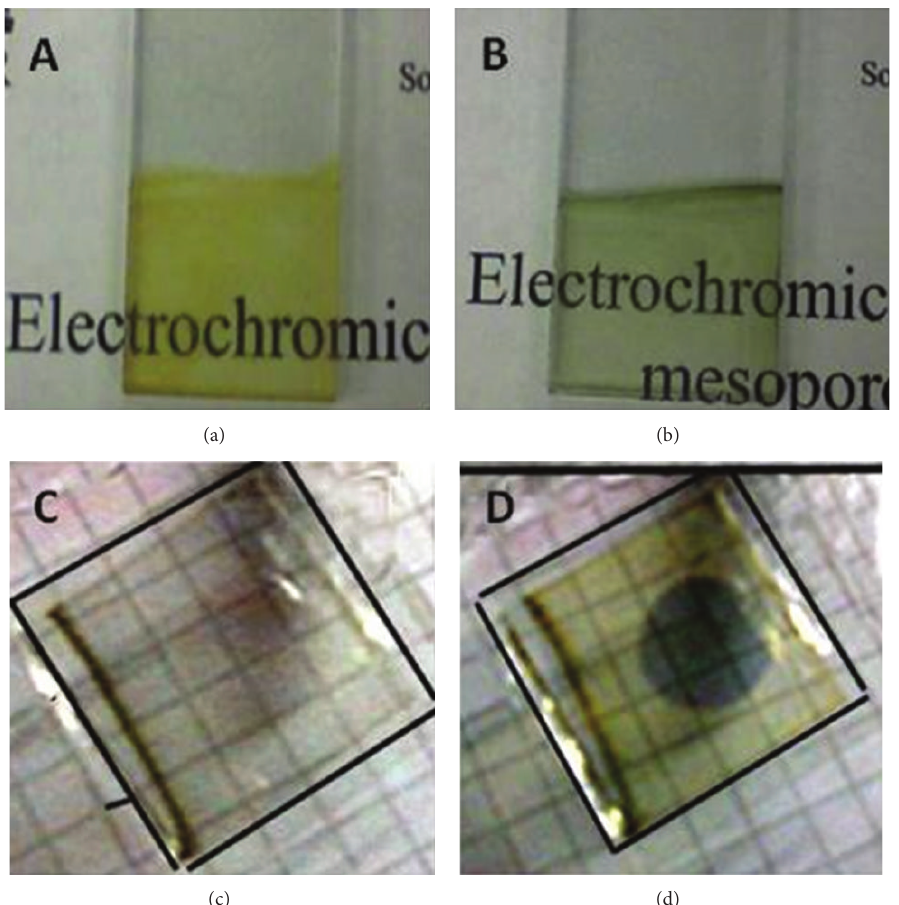
Figure 4: Electrodes appearance in electrochromic devices. (a) electrodeposited V 2 O 5 on glass/ITO in the oxidized and (b) reduced form; (c) and (d) are respectively the bleached and coloured forms of the complete cell with sputtered WO 3 on ITO coated glass (cathode, working electrode) and V 2 O 5 on PET/ITO (anode, counter, and reference electrode).